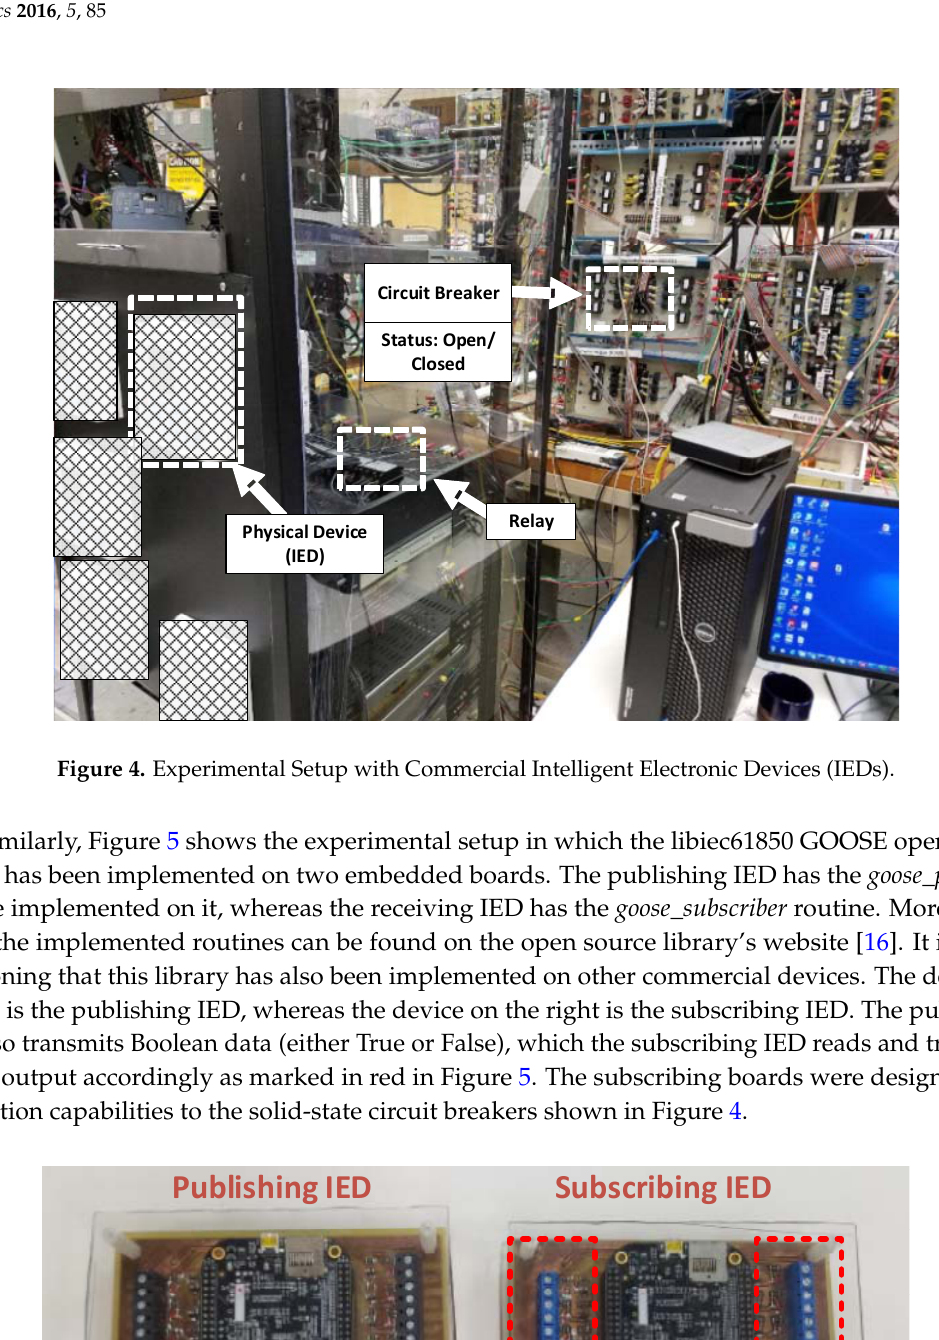
Figure 5. Experimental Setup with libiec61850 Implemented on Embedded Boards.